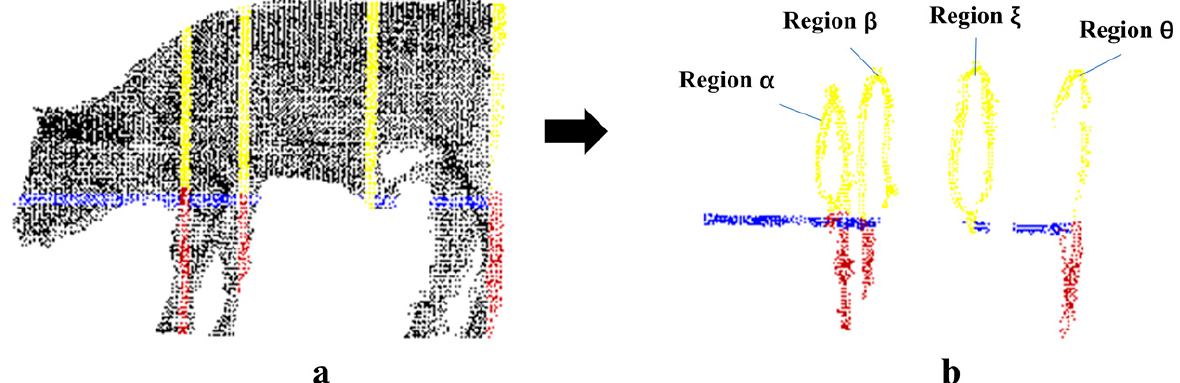
Figure 13. The results of key region extraction for ( a ) the original beef cattle point clouds and ( b ) the extracted regions for body dimension calculation.